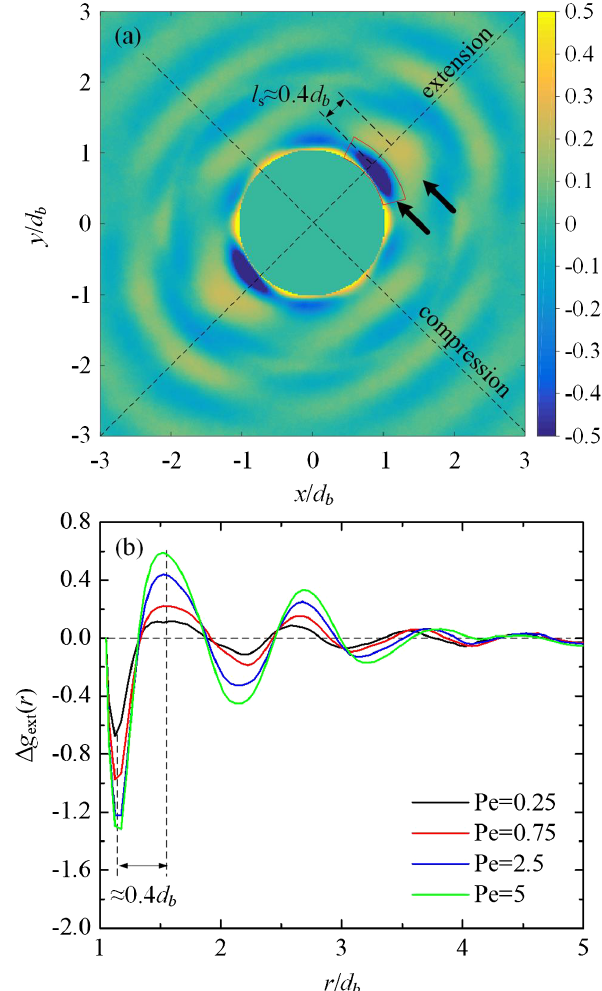
r Þ − g r Þ in the x – y FIG. 7. (a) The slice of Δ g ð r Þ ¼ g liq ð aff ð r Þ is given by the pair distribution function of the flow plane. g liq ð r Þ is the pair distribution at Pe ¼ 0 . 75 and ϕ ¼ 45% . g aff ð function obtained by affinely shearing the equilibrium structure of the ϕ ¼ 45% system with the strain of ¯ γ ¼ 0 . 095 . The thickness of the slice is 0 . 8 d . Two arrows denote the basin b and the peak on the extensional axis. (b) The profiles of Δ g ð r Þ r Þ , at Pe ¼ 0 . 25 , 0.75, 2.5, and along the extensional axis, Δ g ext ð 5 for the ϕ ¼ 45% system. The first negative peak and the first r Þ , respectively, correspond to the basin positive peak of Δ g ext ð and peak denoted by arrows in (a). The distance between these two peaks is about 0 . 4 d b